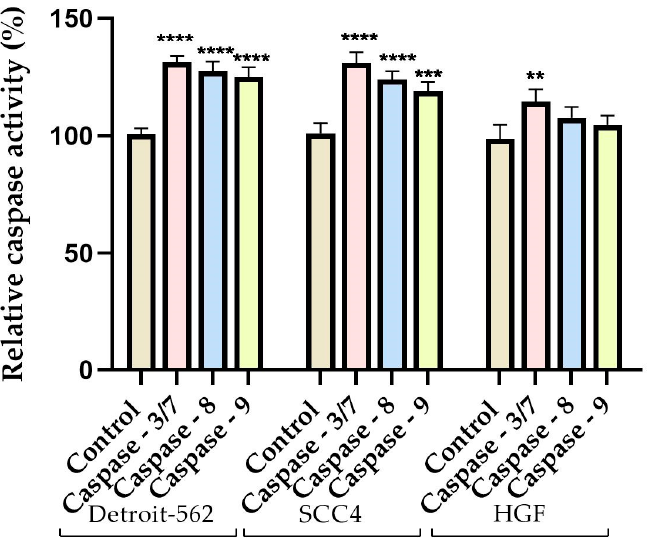
Figure 11. Induction of caspases-3/7, 8, and 9 in Detroit-562, SCC4, and HGF cells, after UVB (2.5 J/cm 2 ) exposure. Data are presented as mean ± SD of the three independent experiments, in reference to the non-exposure group. One-way ANOVA and Dunnett’s post hoc test were used to identify the statistical differences (** p < 0.01; *** p < 0.001 and **** p < 0.0001). The tumor cells exhibited increased luminescence after UVB exposure at a dose of 5 J/cm 2 , which indicated a significant increase in the activity of caspase-3/7. Furthermore, an important increase was also observed in the activity of caspases-8 and 9. In the gingival fibroblasts, similar changes were observed, with all the analyzed caspases showing increased activity. According to a statistical analysis, caspases-3/7 and 8 exhibited the greatest increase in activity (Figure 12).